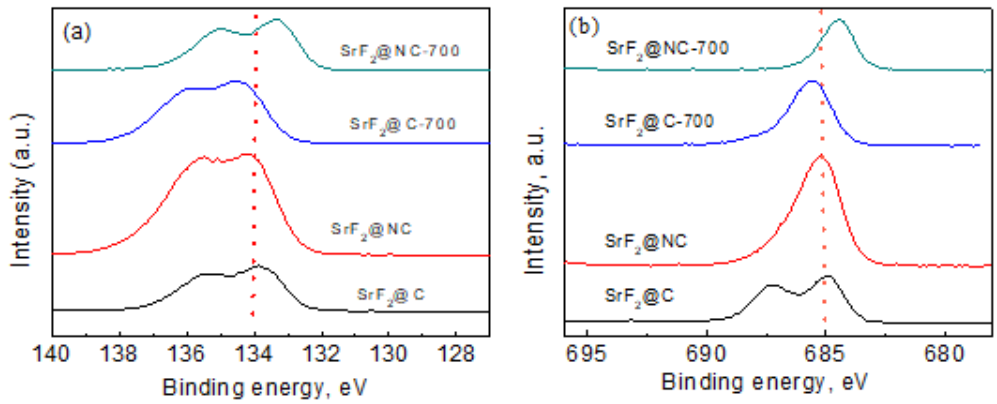
Figure 11. High-resolution XPS spectra of ( a ) Sr 3d and ( b ) F 1s for SrF 2 @C, SrF 2 @C-700, SrF 2 @NC, and SrF 2 @NC-700 catalysts.